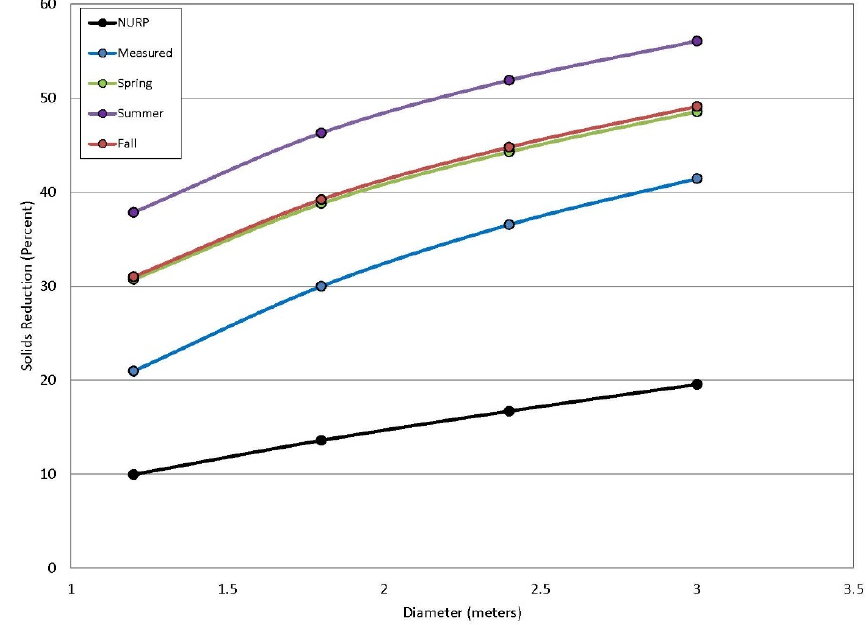
Figure 6. Increasing percentage of solids removed with increasing diameter of two catch basins in the commercial parking